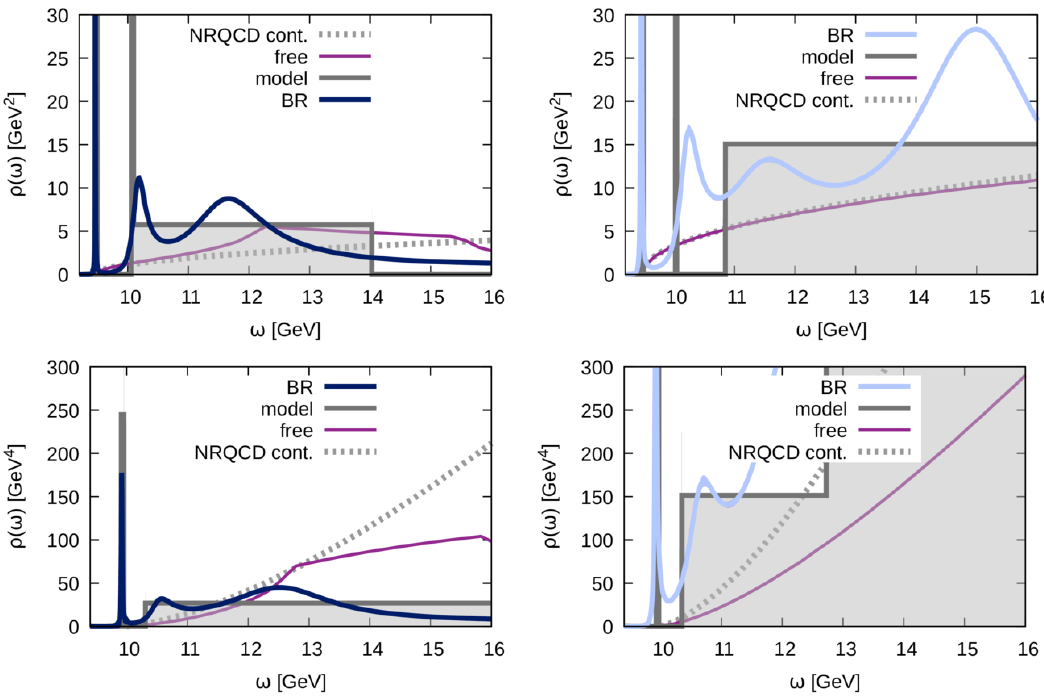
Figure 11 . Constrained model (cid:12)ts (gray) compared to the spectral reconstruction based on the standard BR method at T = 0. The top two panels show S-wave bottomonium on the coarsest (cid:12) = 6 : 664 (right) and (cid:12)nest (cid:12) = 7 : 825 (left) lattices. The lower two panels on the other hand contain the results for P-wave bottomonium again for both the coarsest (cid:12) = 6 : 664 (right) and (cid:12)nest (cid:12) = 7 : 825 (left) lattices.